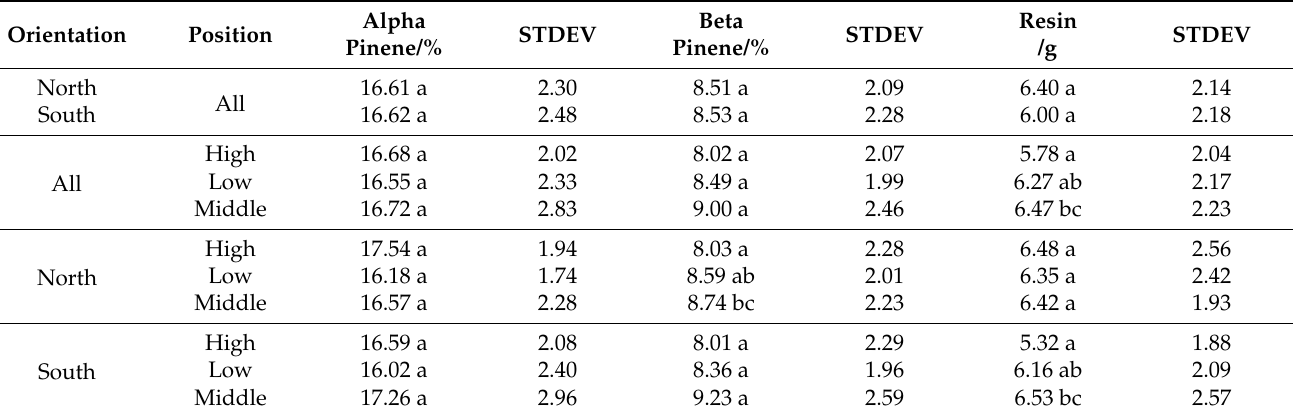
Figure 5. The α -Pinene and β -pinene contents and resin productivity for the trees in different plots and their comparison (( A ): North vs. South slope; ( B ): Elevation; ( C ): North slope; ( D ): South slope). Duncan’s multiple-range test; means with the same letter are not significant ( p < 0.05). Table 4. The α -pinene and β -pinene contents and resin productivity for the trees in different plots and their multiple comparisons